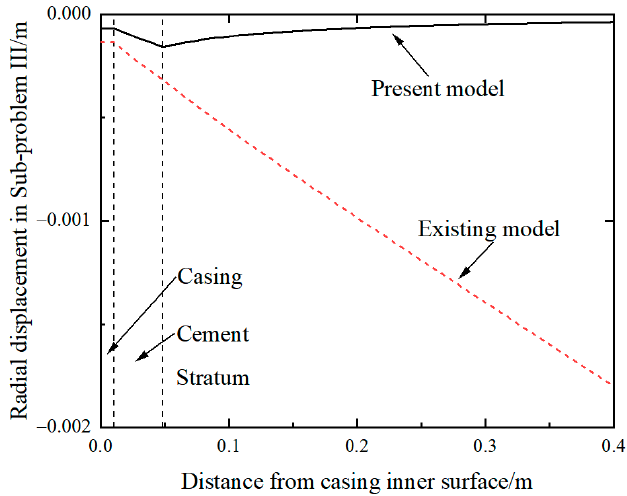
Figure 6. Radial displacement along 0 ◦ direction with increasing radius in the anti-plane shear Sub-problem III. The radial displacement in stratum increases linearly with increasing radius, which implies unrealistic infinite displacement at